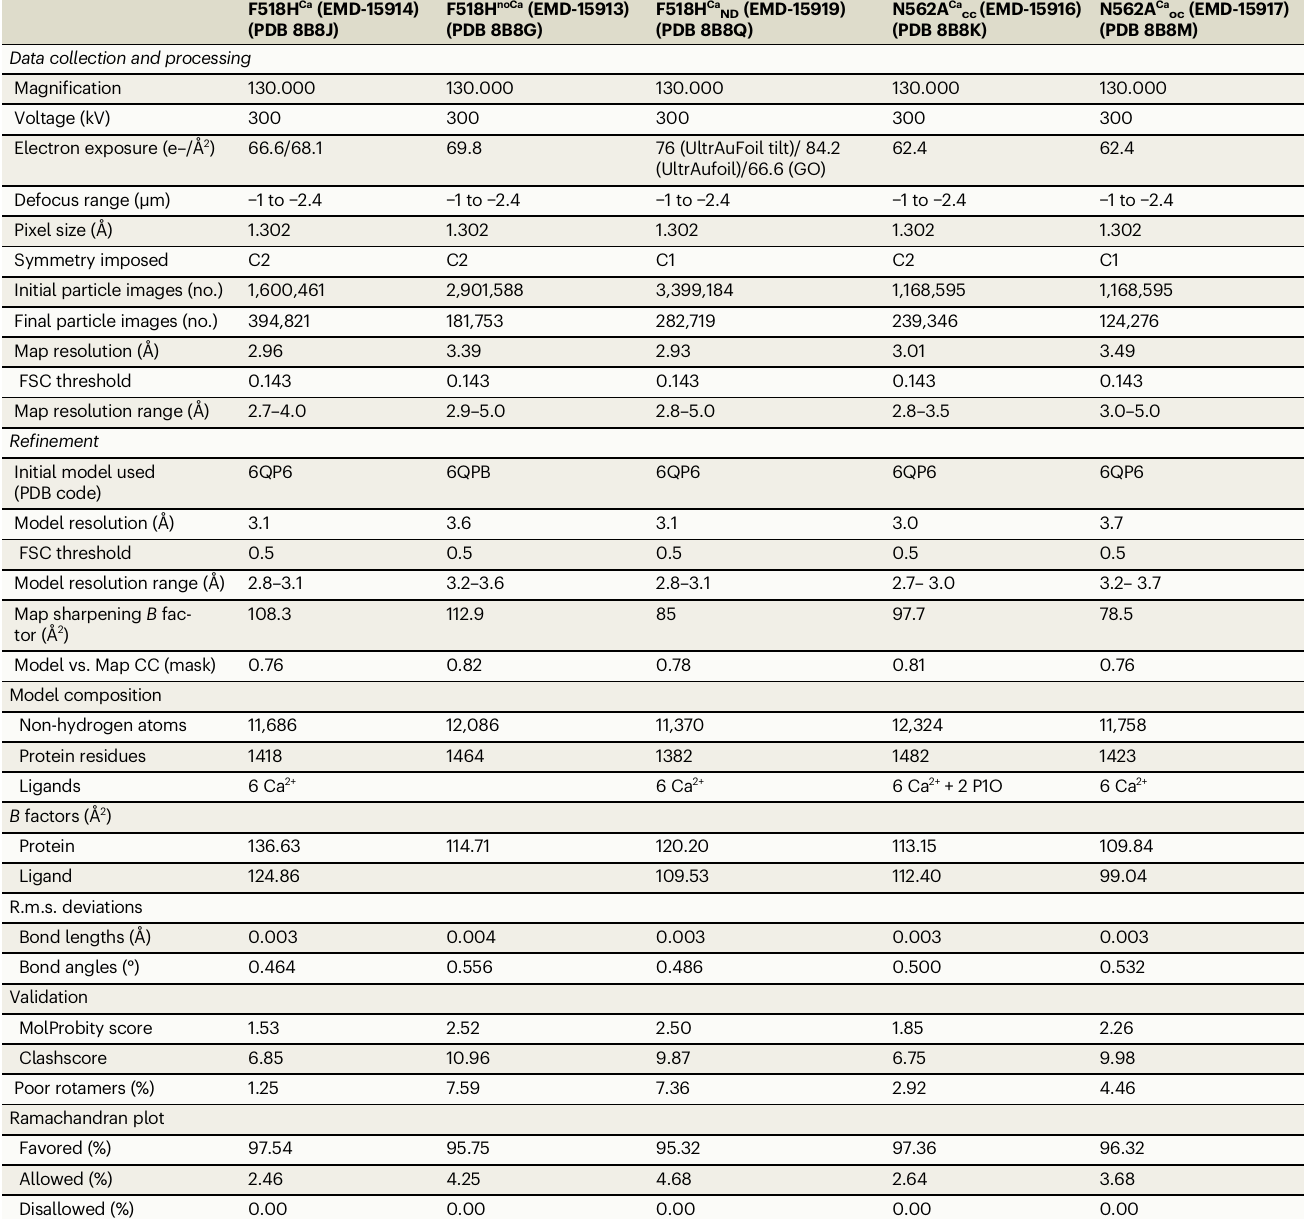
Table 1 | Cryo-EM data collection, processing, re fi nement and validation